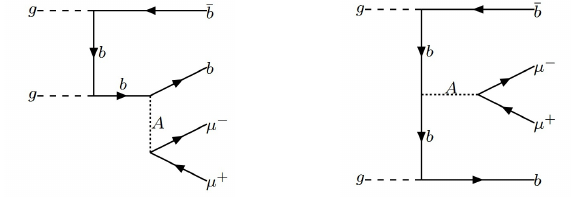
Figure 3. Feynman diagrams with production and decay of a CP-odd Higgs boson A associated with